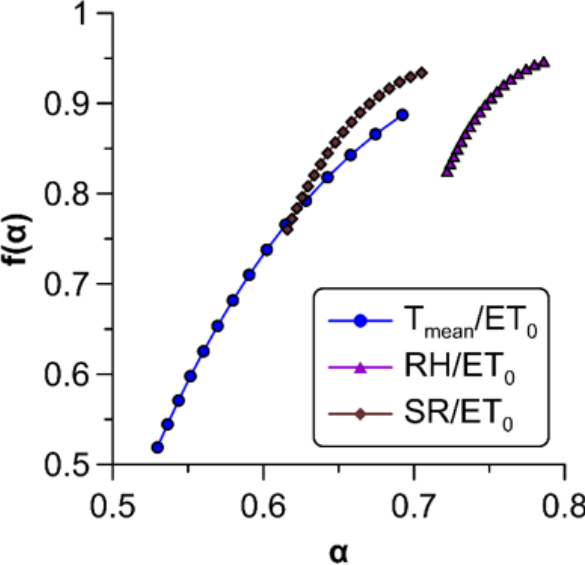
Figure 7. Multifractal spectra of various pairs of cross-correlations with 𝐸𝑇 0 .